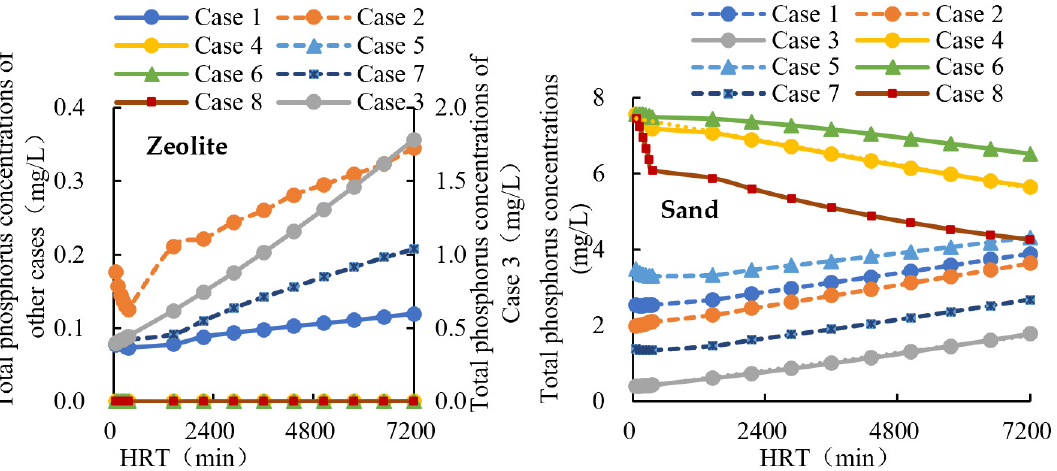
Figure 10. TP concentrations with different straw